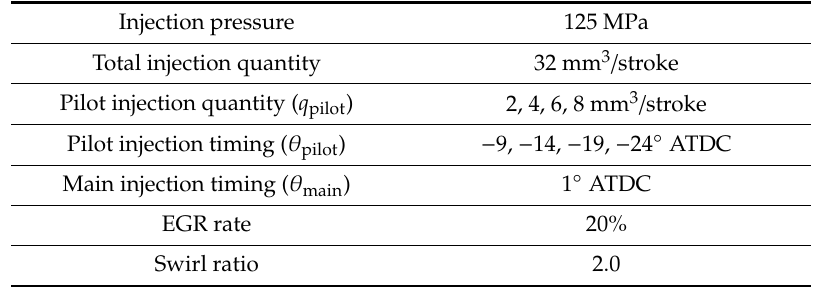
Table 2. Engine operating